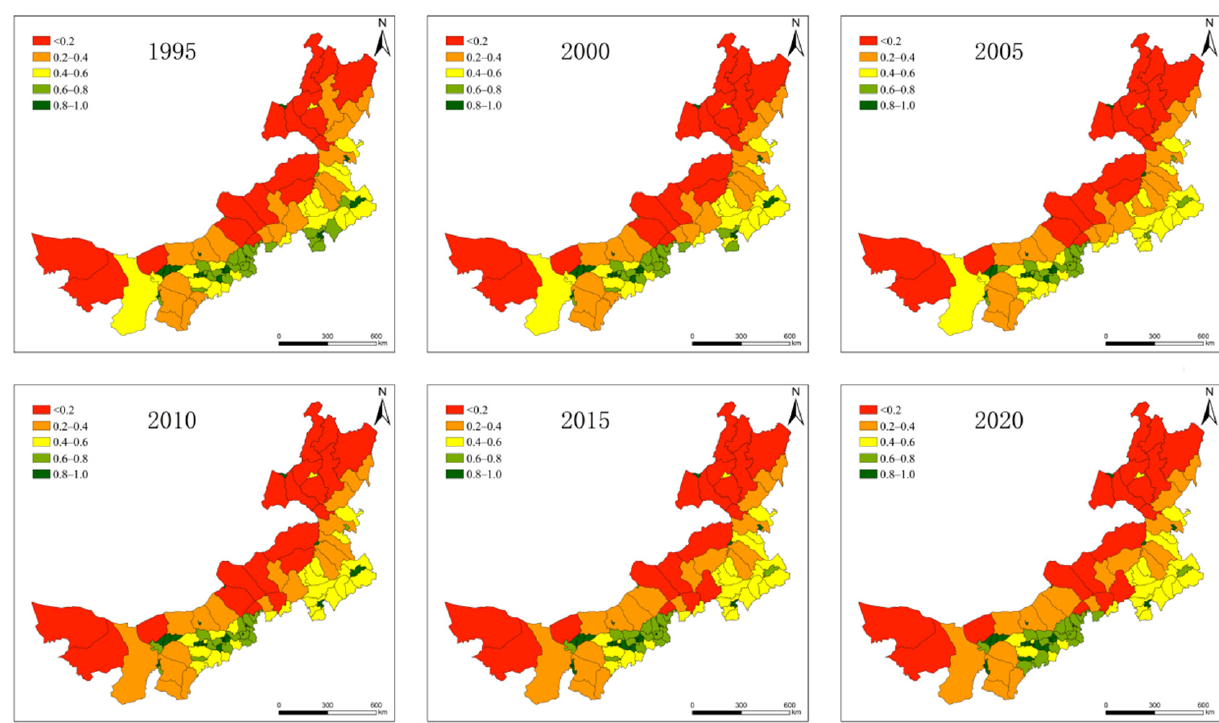
Figure 6. Coupling degree of ESs and urbanization in Inner Mongolia from 1995 to 2020.